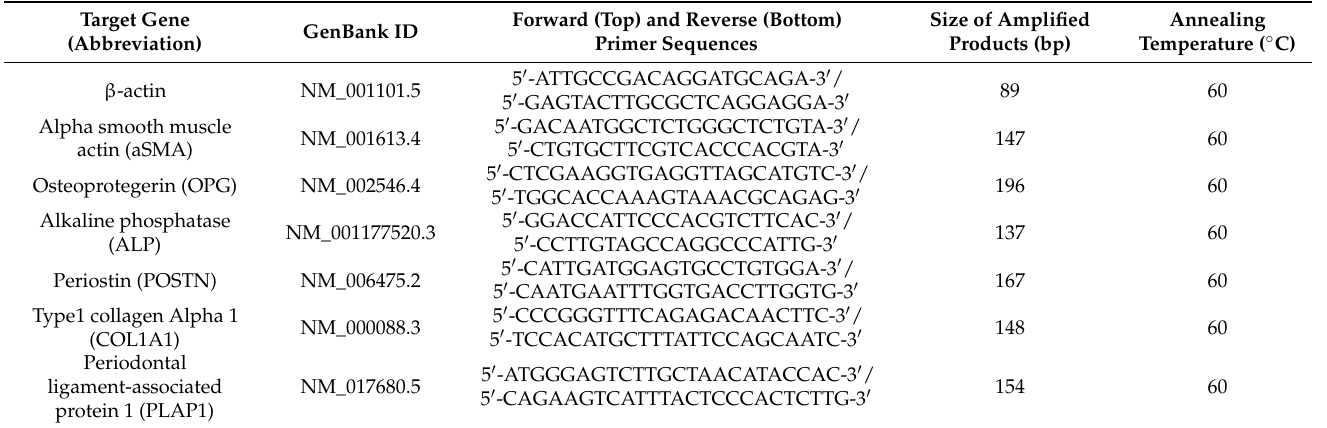
Table 1. GenBank ID, primer sequences, product sizes, and annealing temperatures for quantitative reverse transcription polymerase chain